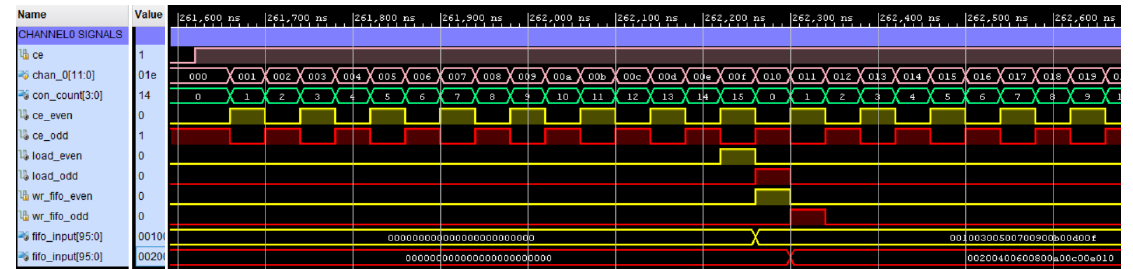
Figure 10. Simulation of incoming data to the swapping module for channel 0.